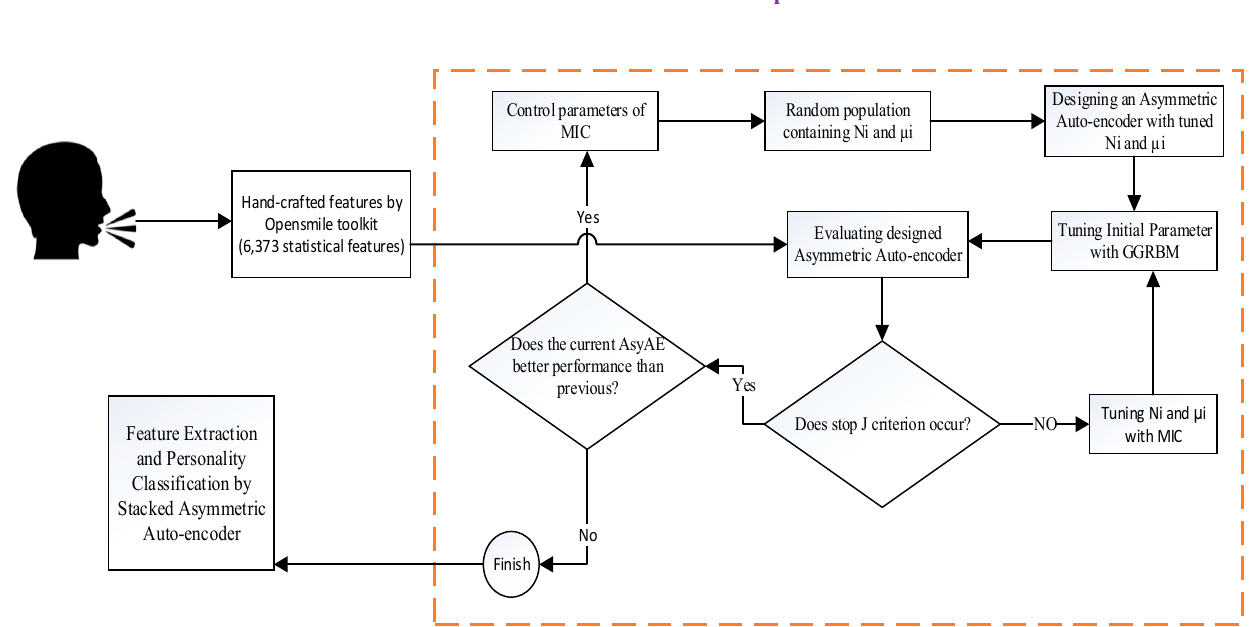
Figure 3. Flowchart of SA AE hyper-parameter optimization.